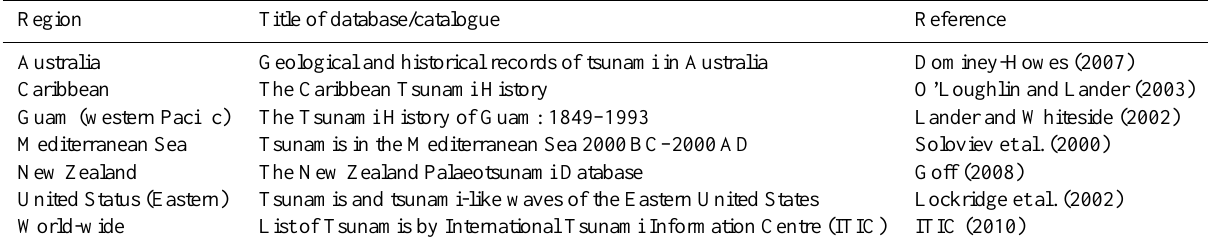
Table 1. Examples of regional tsunami databases/catalogues from other areas around the world.